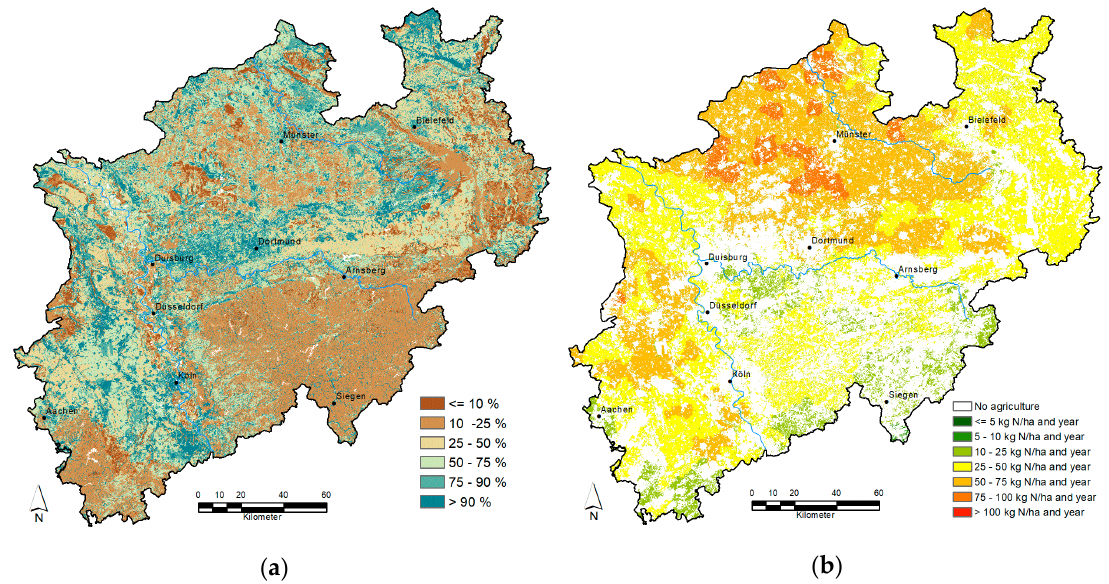
Figure 4. ( a ) Denitrification losses in soil relative to the displaceable N surplus in soil, and ( b ) N output from soils originating from agricultural sources.